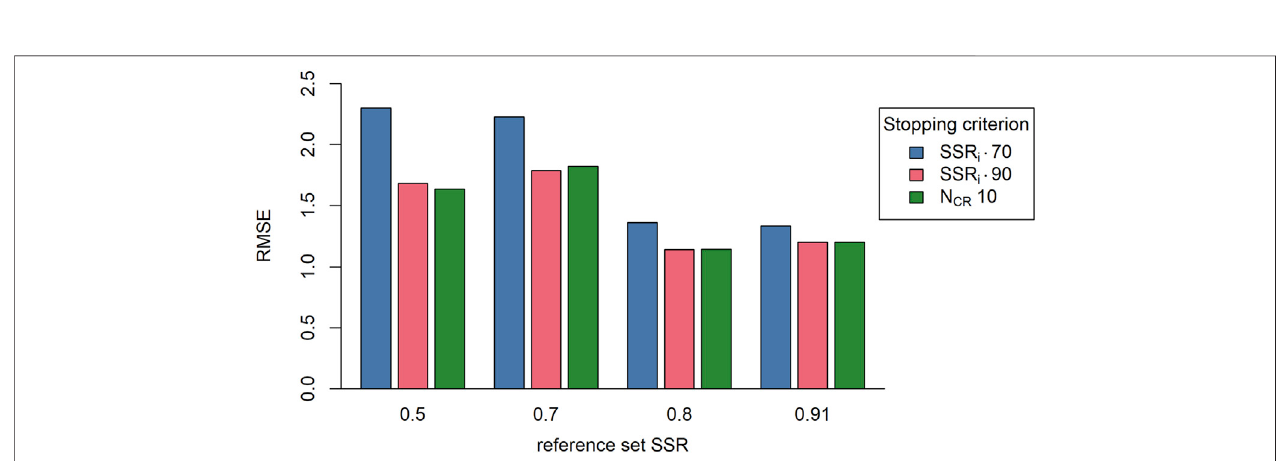
FIGURE 4 | The root mean squared error (RMSE; n = 20) per reference set (SSR of reference sets) and per stopping criterion (colors; SSR i 0.70, SSR i 0.90, N CR 10). Note: SSR i, = estimate reliability; N CR, = number of comparisons per